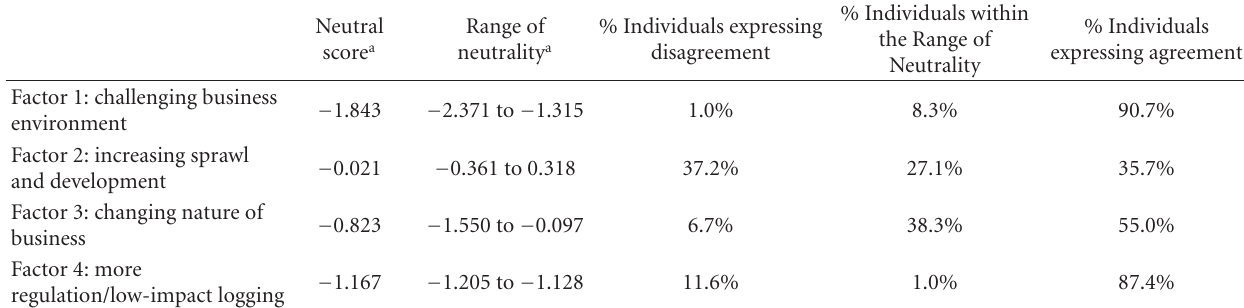
Table 2: Factor analysis neutrality results with percent of individuals expressing disagreement, neutrality, and agreement to each